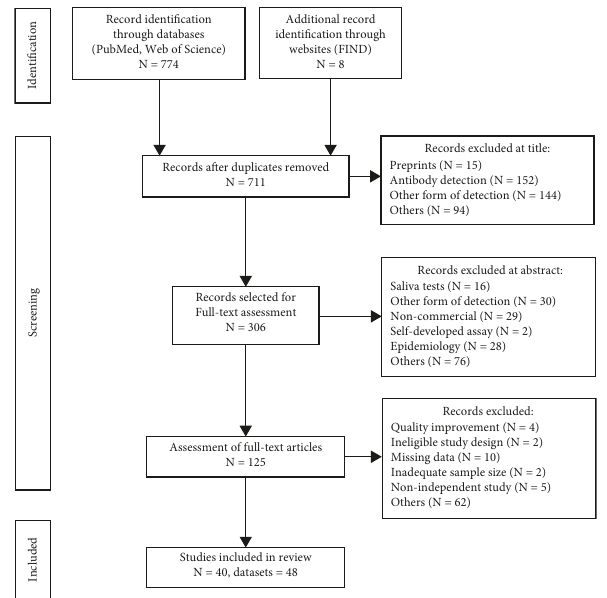
Figure 1: PRISMA flow-diagram showing systematic study pro- cessing (FIND: